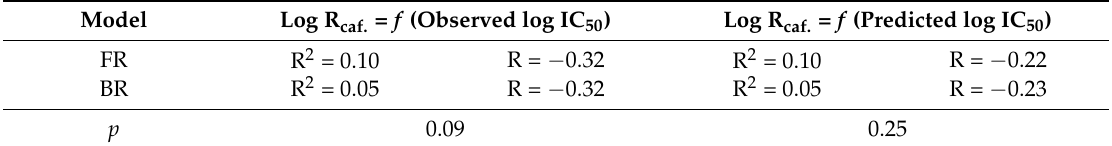
Figure 2. Observed and predicted log IC 50 of ACE-inhibiting/bitter dipeptides: ( a ) FR and ( b ) BR. The dashed line denotes the confidence interval. Table 3. Correlations between dipeptide ACE inhibition and bitterness obtained for the FR and BR models ( α =